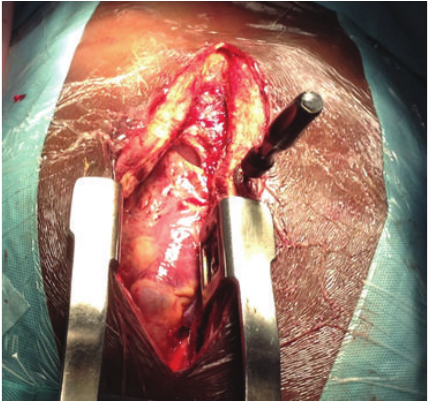
Figure 3: Image of screwdriver remaining after sternotomy.